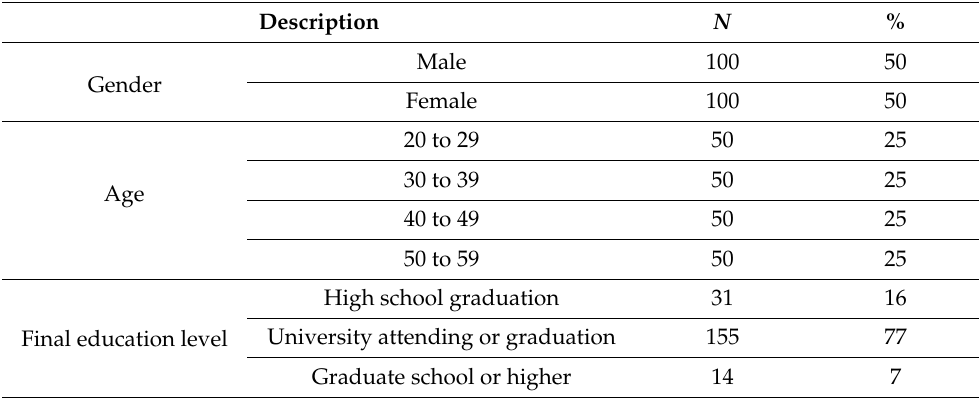
Table 2. Summary